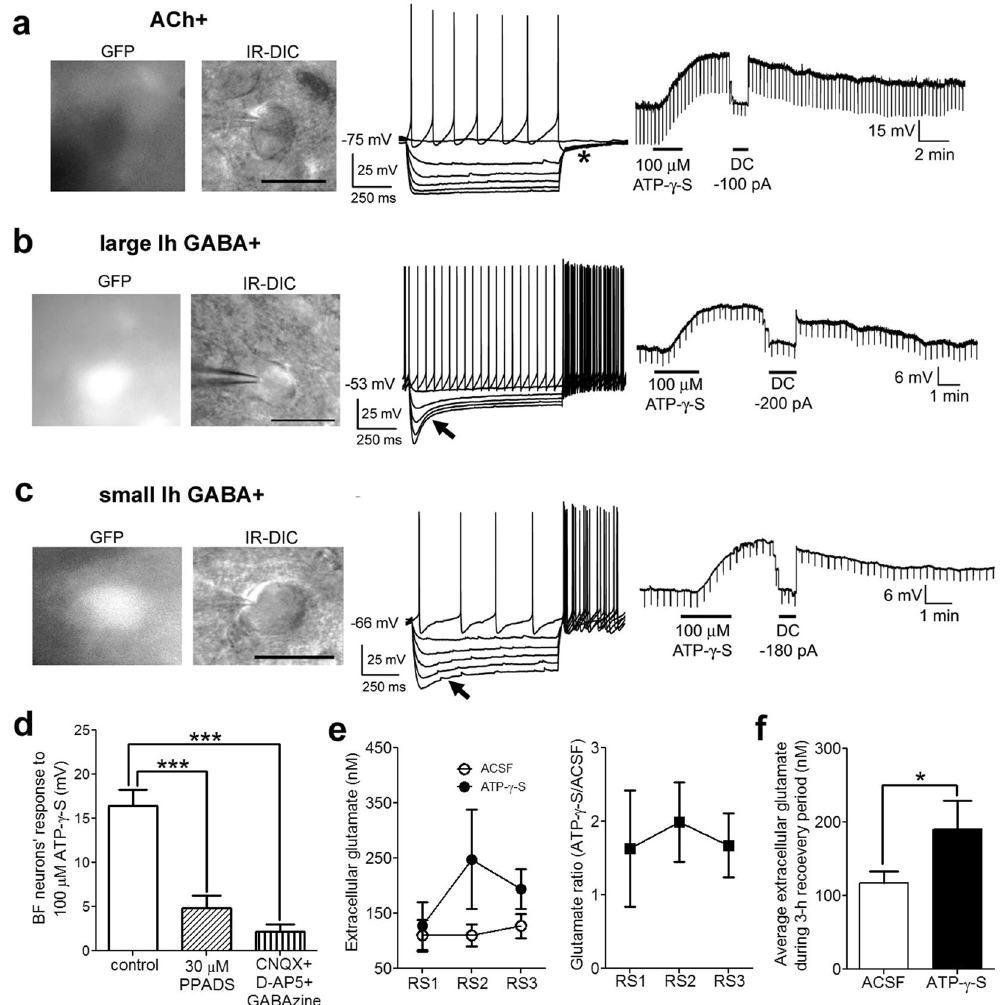
Figure 2. The P2R agonist, ATP- γ -S, excites basal forebrain (BF) cortically-projecting wake-active cholinergic and GABAergic neurons and increases local glutamate release. ( a–c ) Identification and responses of BF cholinergic (Ach + ), and two types of large-sized GABAergic (large Ih GABA + and small Ih GABA + ) to the P2R agonist ATP- γ -S in vitro . Left: Black-and-white fluorescent and infra-red-differential interference contrast (IR-DIC) images of the recorded neurons in slices prepared from GAD67-GFP knock-in mice. In these mice, GFP is selectively located in GABAergic neurons, with cholinergic neurons being GFP negative. Scale bar: 25 µ m. Middle : Characteristic voltage responses of cholinergic and cortically-projecting GABAergic neurons in response to hyperpolarizing and depolarizing current injection. Cholinergic neurons exhibit a delayed return to baseline following hyperpolarizing current pulses due to an A-type potassium current (asterisk, A ) whereas GABAergic neurons demonstrate a depolarizing sag during hyperpolarizing current steps due to activation of the hyperpolarization-activated-inward current (Ih, black arrow, b and c ). We previously characterized these neurons in detail 27,31 . Right: All three types of neurons were depolarized by ATP- γ -S in the presence of tetrodotoxin (TTX). (d ) Summary of BF neuronal voltage responses to 100 µ M ATP- γ -S in control (500 nM TTX, n = 17) and marked attenuation of the response in the presence of a P2XR antagonist (500 nM TTX + 30 µ M PPADS, n = 16), or in the presence of a cocktail of glutamate & GABA A receptor antagonists (500 nM TTX + 20 µ M CNQX + 50 µ M D-AP5 + 10 µ M GABAzine. n = 8) tested using a one-way ANOVA with Bonferroni post-hoc test. *** p < 0.001. (e and f ) In vivo hourly measurements of extracellular glutamate concentration and average glutamate concentrations with ACSF/1 mM ATP- γ -S infused during the 3 h recovery period after sleep deprivation, showing that ATP- γ -S increases extracellular glutamate concentrations in the BF. RS1/2/3: recovery sleep hour 1/2/3. n = 6. Paired-t-test. * p <